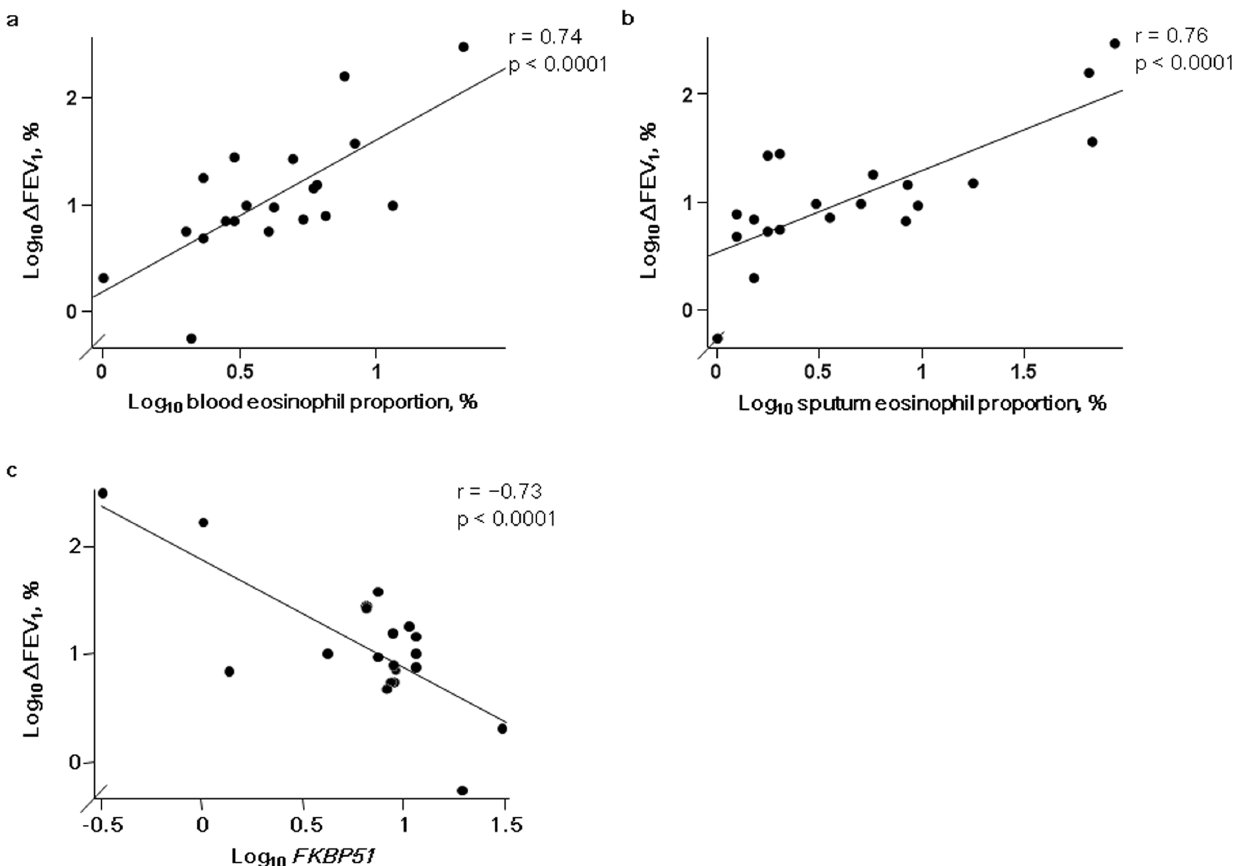
Figure 4. Associations between changes in FEV 1 after ICS initiation and pretreatment eosinophilic inflammation and FKBP51 levels. Associations between changes in FEV 1 after ICS initiation and pretreatment a) blood and b) sputum eosinophil proportions and c) FKBP51 mRNA levels normalized to b 2 microglobulin mRNA levels in steroid-naı¨ve patients with asthma (n=20). Abbreviation: FEV 1 , forced expiratory volume in one second; ICS, inhaled corticosteroid.